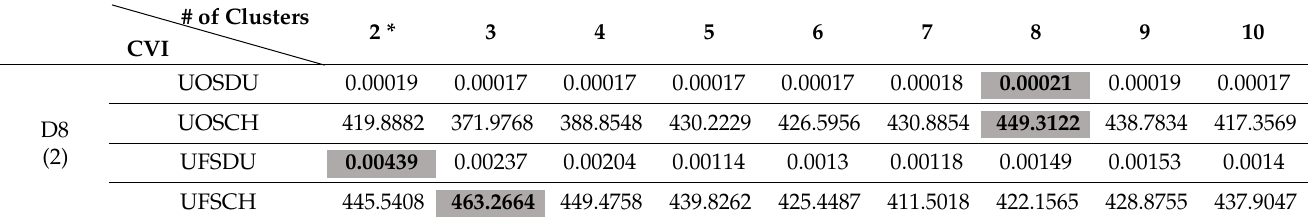
Table 9. Performance results for